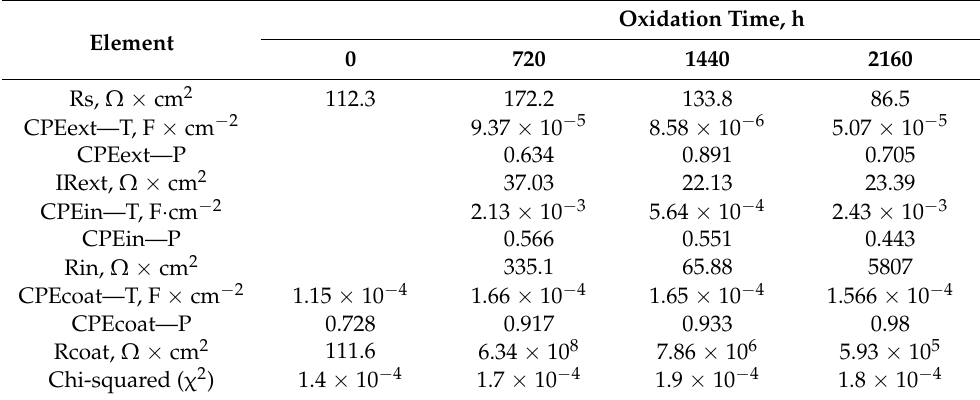
Table 4. The values of EEC elements for CrN x -coated 310 H SS samples before and after different periods of oxidation in water at 550 °C and 25 MPa.